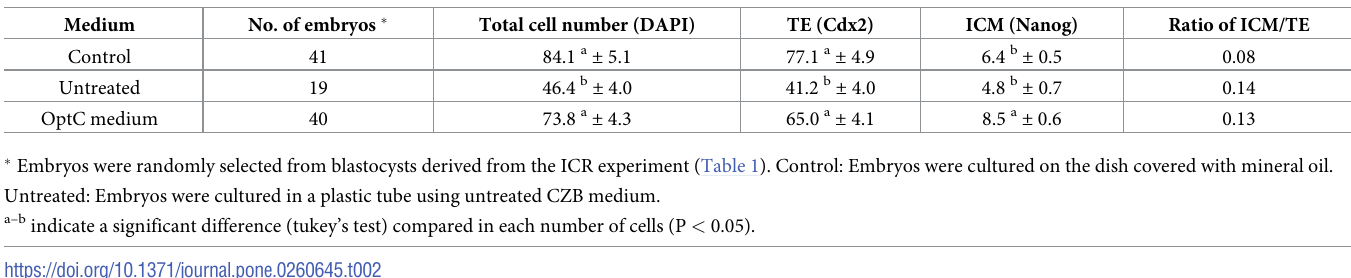
Table 2. Cell number of blastocysts cultured in sealed tube with OptC medium.